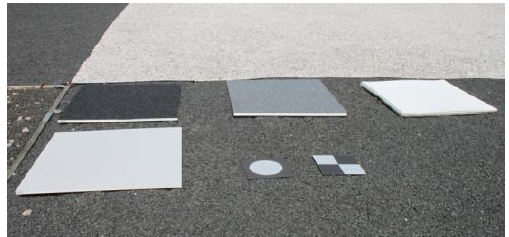
Figure 3. Black, grey, light grey and white reflectance panels of size of 1 m x 1 m.